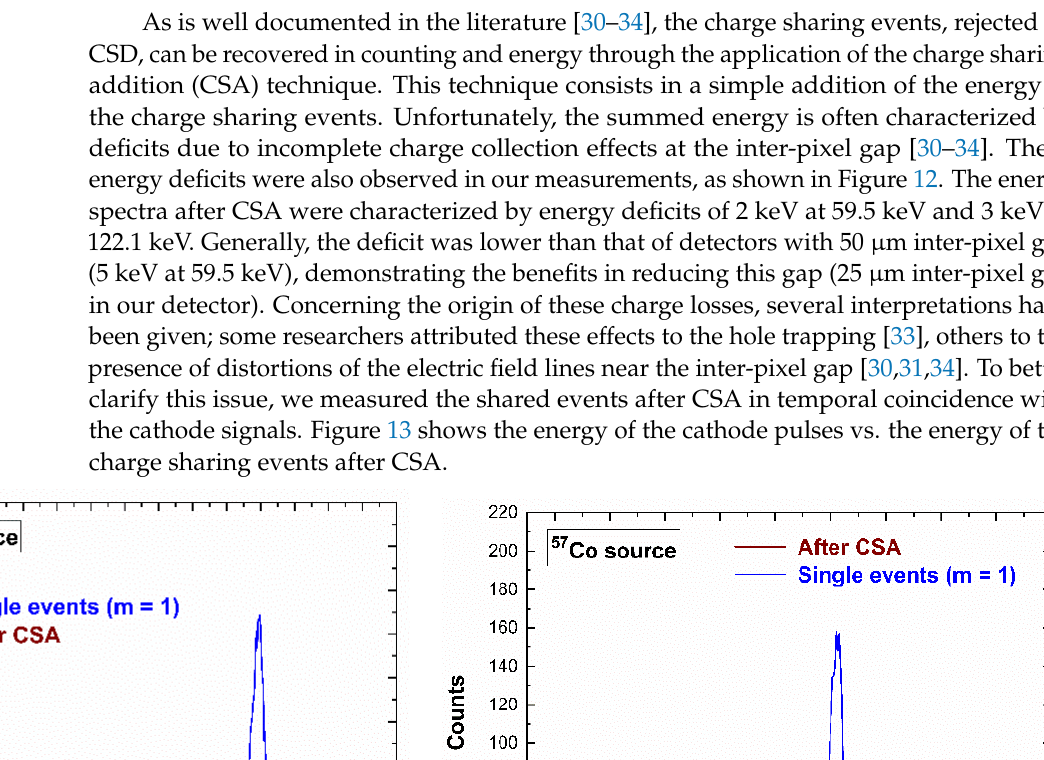
Figure 13. Scatter plot of the energy of the cathode events vs. the energy of the shared events after CSA. The presence of energy deficits (about 2 keV at 122 keV), even for event interacting near the cathode (i.e., characterized by the full cathode energy of 122 keV and very low hole contribute to the signal), clearly demonstrates that these losses are not related to the hole trapping, but to electric field line distortions at the inter-pixel gap. The dashed red line represents the correct energy after CSA (i.e., 122.1 keV). The curvature of the scatter plot, related to the 122 keV photopeak, highlights that the summed energy changes with the interaction depth (represented by the energy of the cathode). In particular, an energy deficit of about 2 keV at 122 keV was present even for photon interactions near the cathode, i.e., characterized by a full cathode energy of 122 keV. Because photon interactions near the cathode gave pulses with a small hole contrib- ute, the hole trapping cannot justify the charge losses. This confirms that the presence of the energy deficit could be only due to distortions of the electric field lines near the inter- pixel gap.